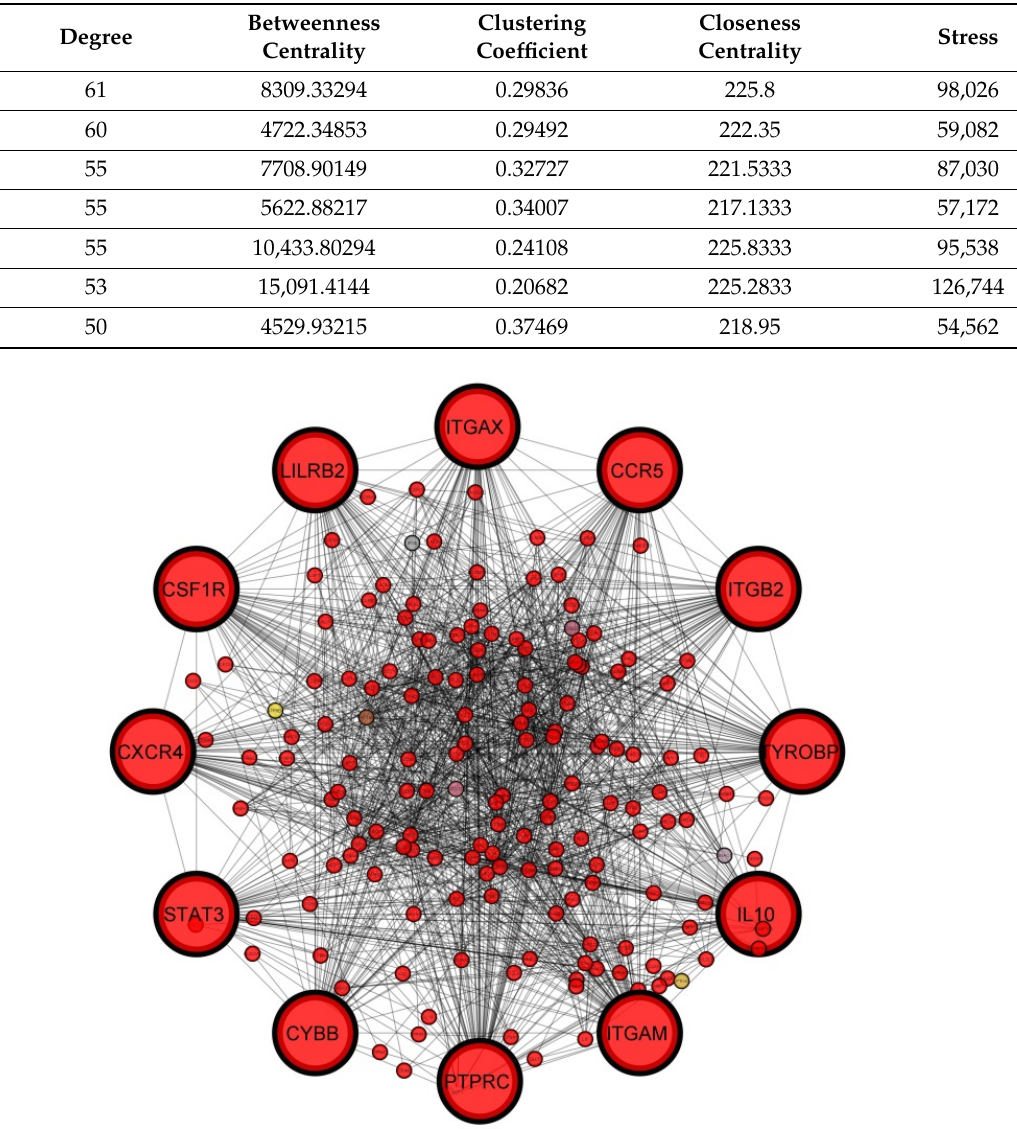
Table 2. Topological parameters for the twelve potential hub genes of the PPI network.